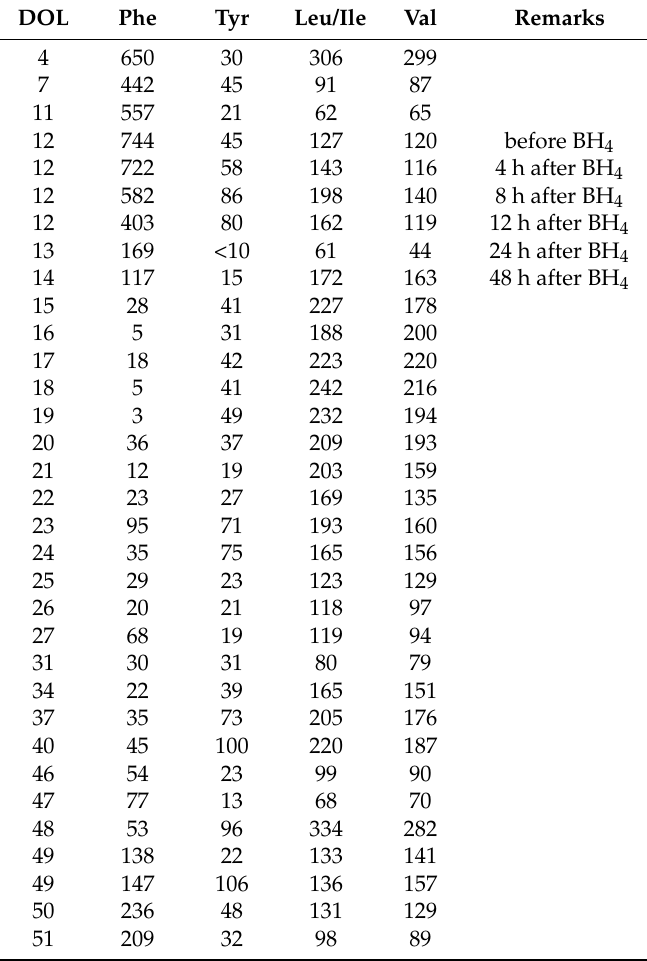
Table 1. Concentration of phenylalanine, tyrosine, leucine/isoleucine, and valine during the first 51 days of life (DOL); measured from dried blood spots (DBS) by tandem MS with the standard newborn screening (NBS) method; concentrations in µ